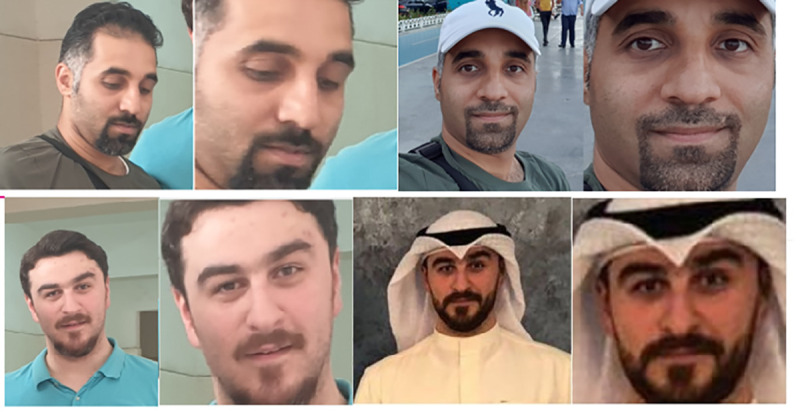
Face images before and after preprocessing (images from dataset published in [18]).